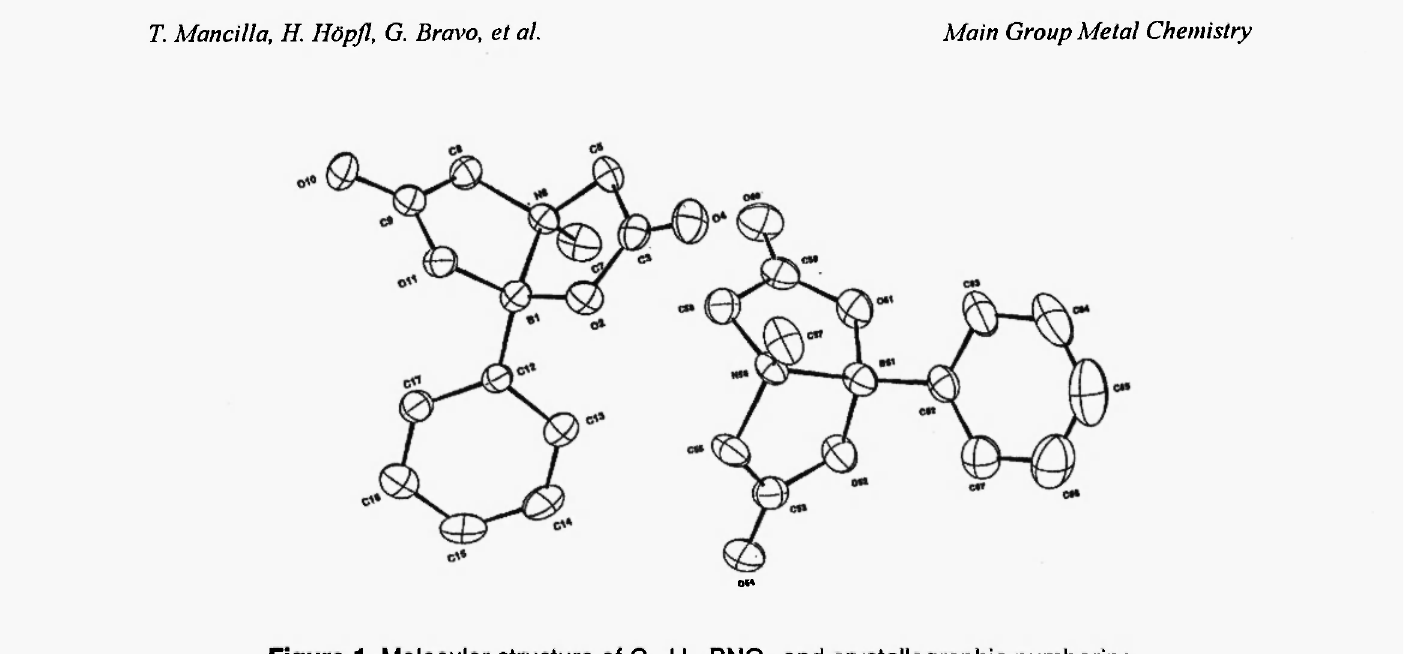
Figure 1. Molecular structure of C11H12BNO4 and crystallographic numbering scheme of the molecules A and B. The molecules in the crystal structure show the following intermolecular contacts (Figure 2): C=O ·Η82 2.476, C=O 10 10 The 0 atom does not participate in a significant intermolecular contact and this explains the short 4 C=C >4 bond distance (1.198(2) Ä) . Besides the intermolecular contacts, there are the following intramolecular contacts, H ...H of 2.250 Ä for A and H ...H of 2.080 Ä for B. 52 81 551 5 82